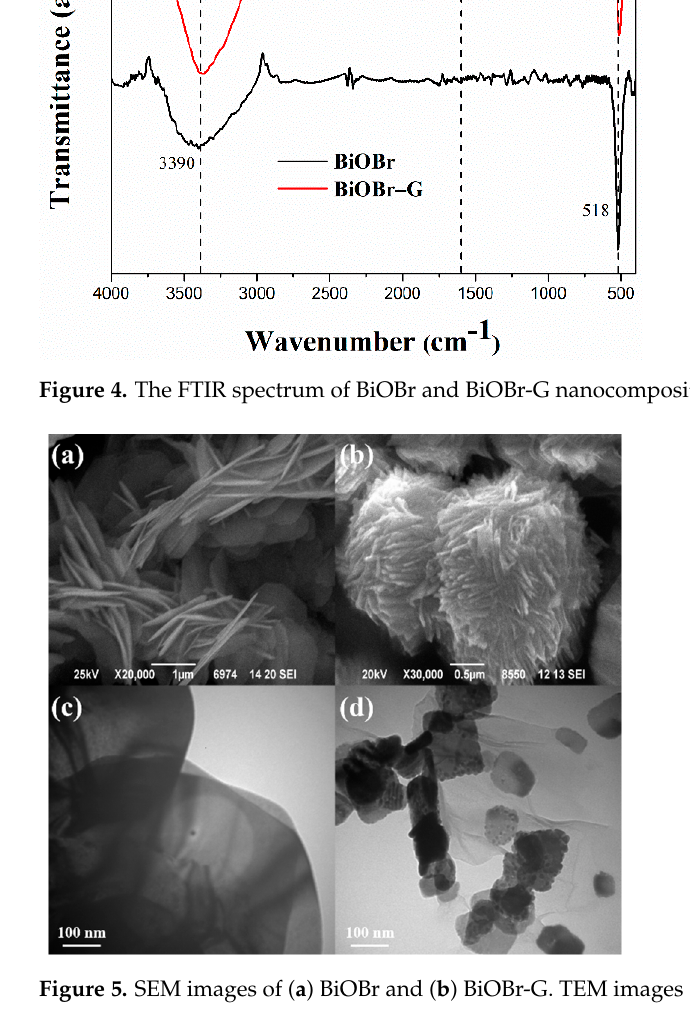
Figure 5. SEM images of ( a ) BiOBr and ( b ) BiOBr-G. TEM images of ( c ) BiOBr and ( d ) BiOBr-G.